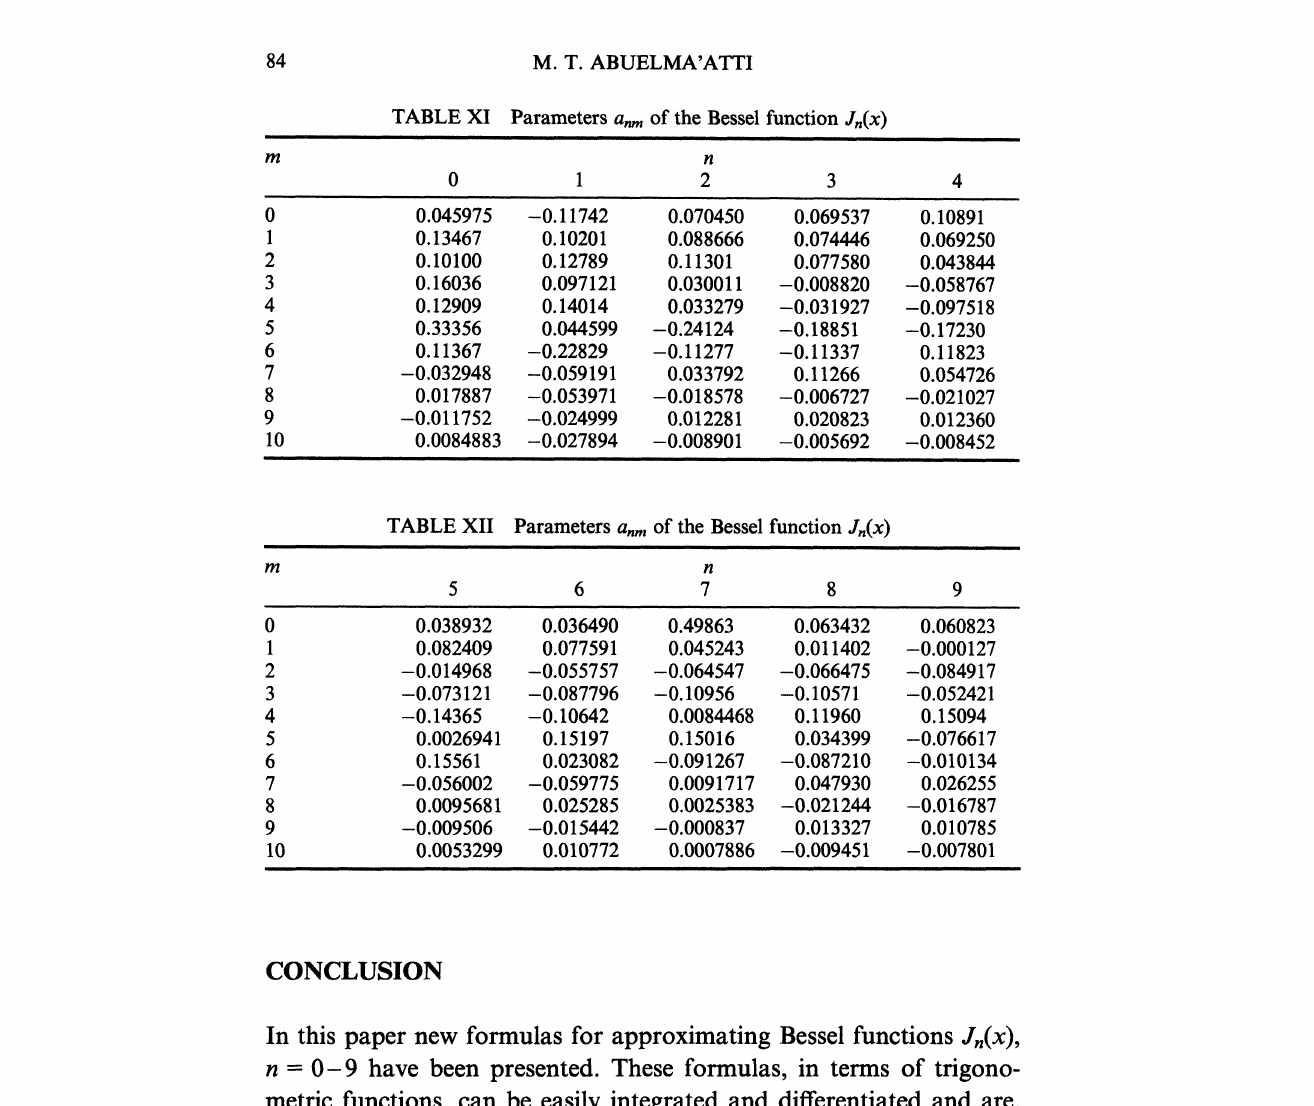
TABLE XI Parameters anm of the Bessel function Jn(x)